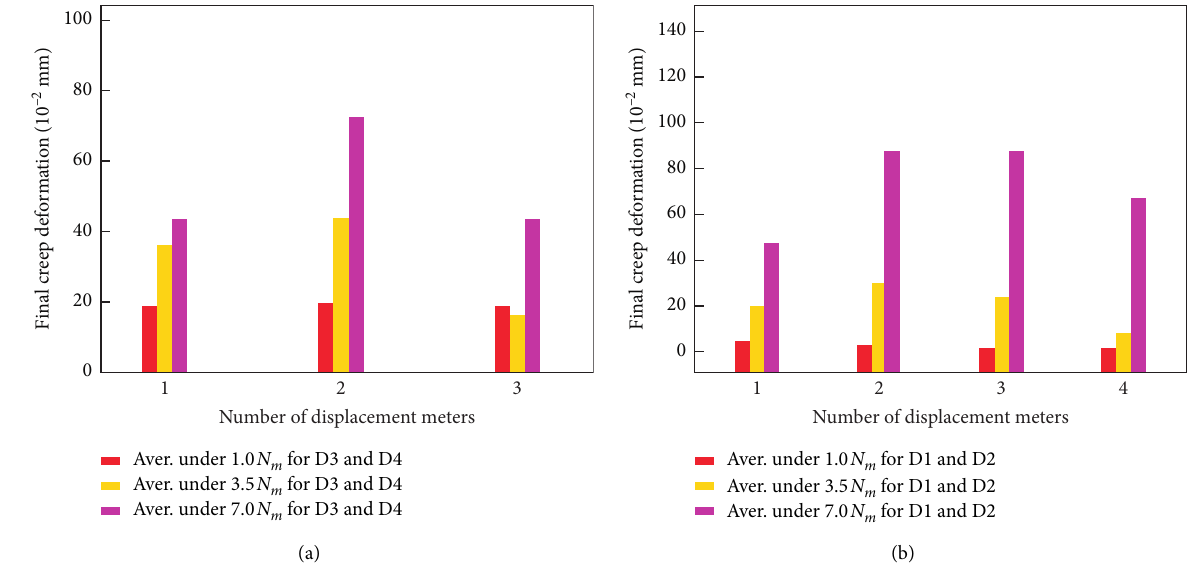
Figure 14: Final creep deformation along the (a) tensile direction and (b) vertical direction in the surrounding rocks.